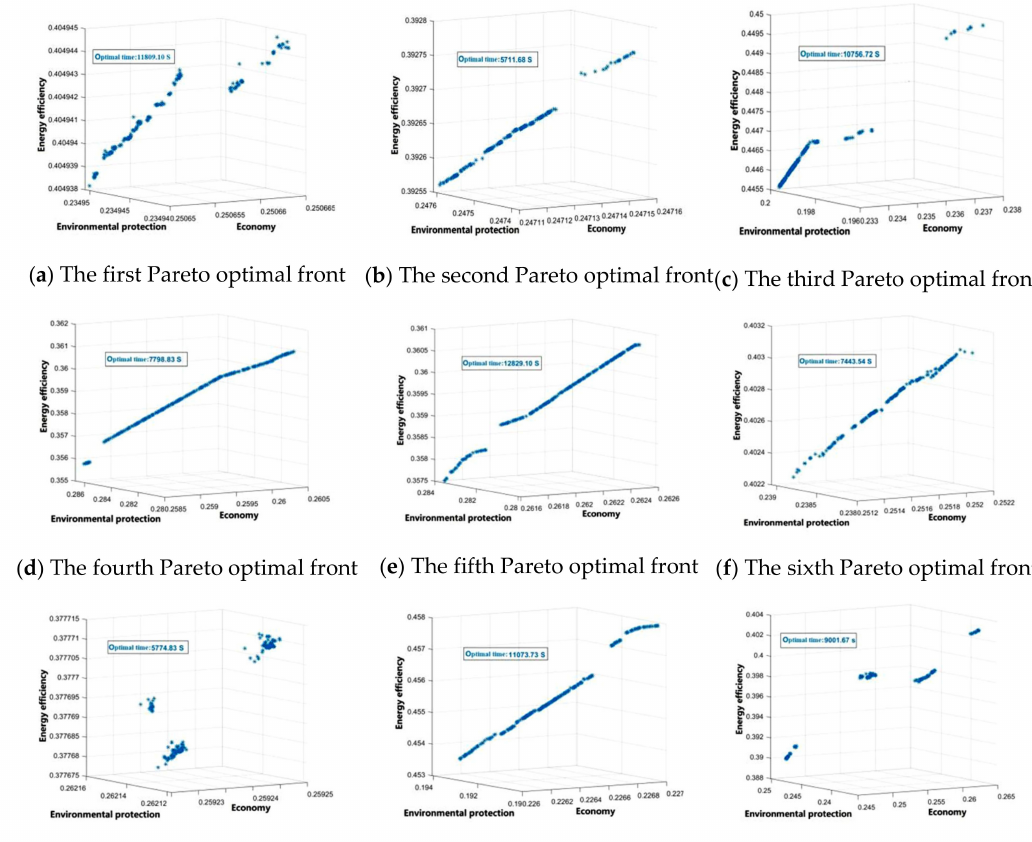
Figure 13. The Pareto fronts obtained via